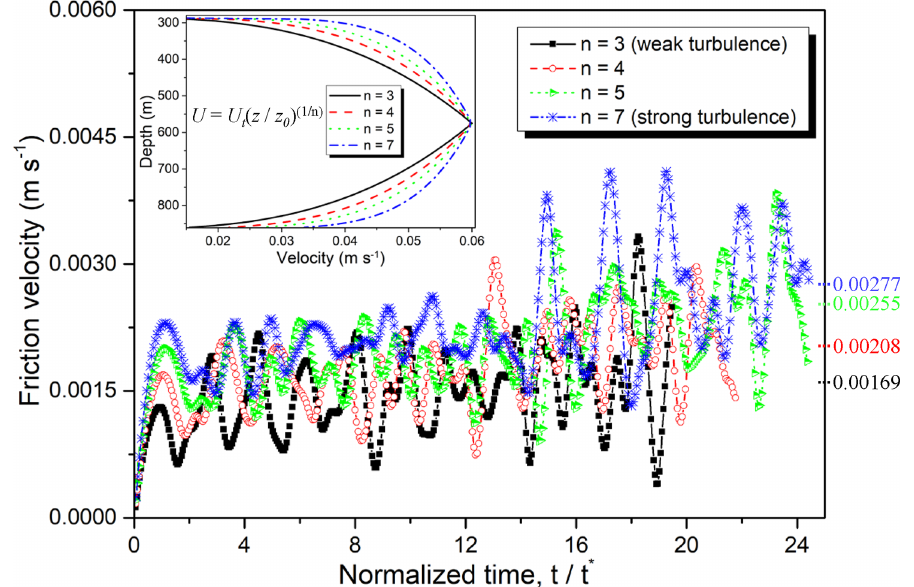
Figure 2. Time series of the friction velocities in all the four cases. The total time (96h) was normalized by each large-eddy turnover time, t ∗ , which was calculated from the overturning eddy scale (ice-shelf–ocean boundary layer (IOBL) scale) divided by the friction velocity. The inset figure shows four different theoretical profiles of the velocity.